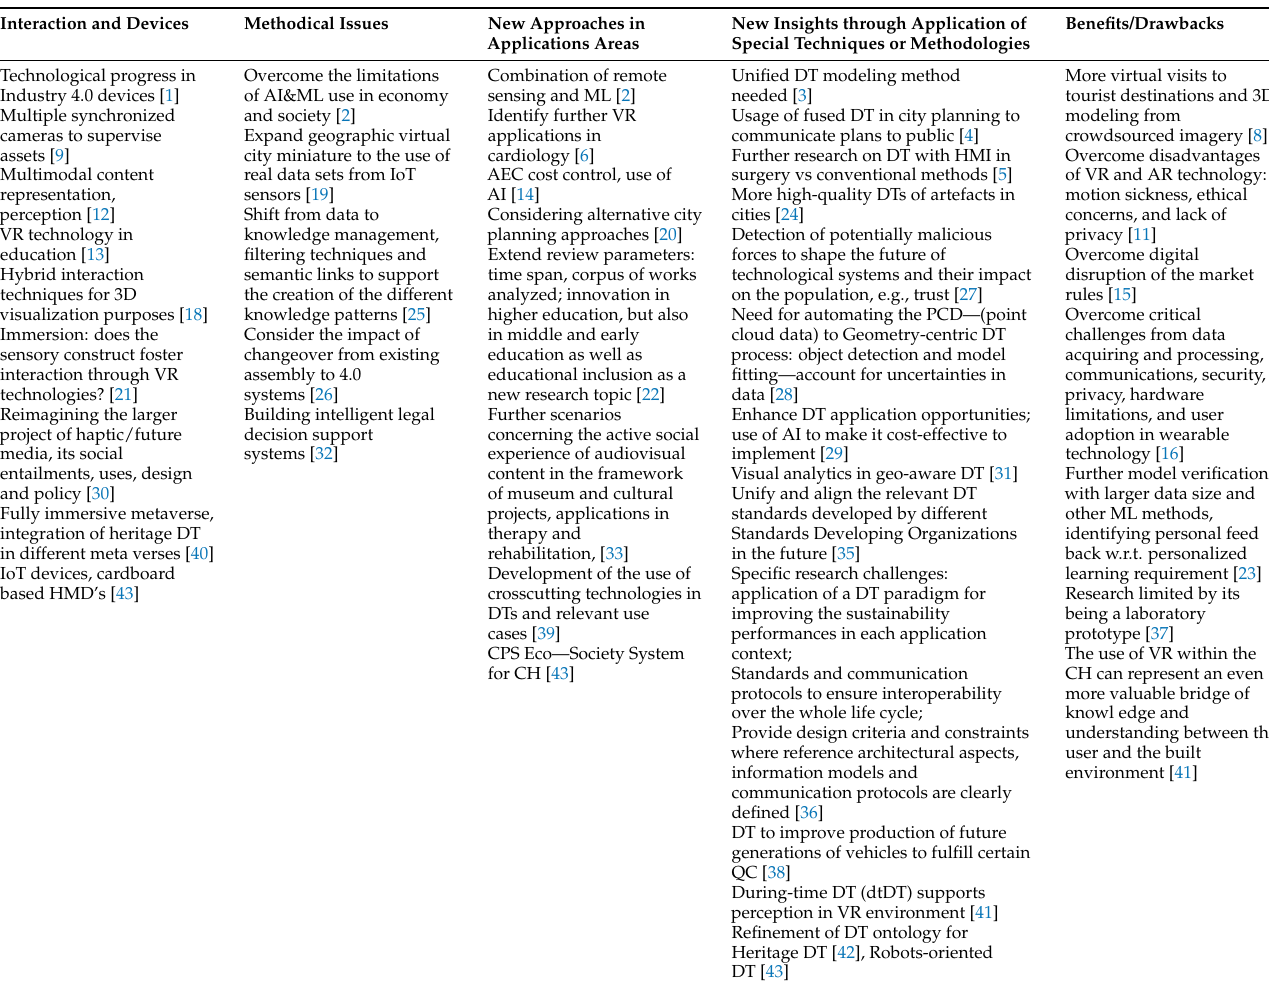
Table 5. Future technical, thematic and methodical work in the light of DT’s benefits and